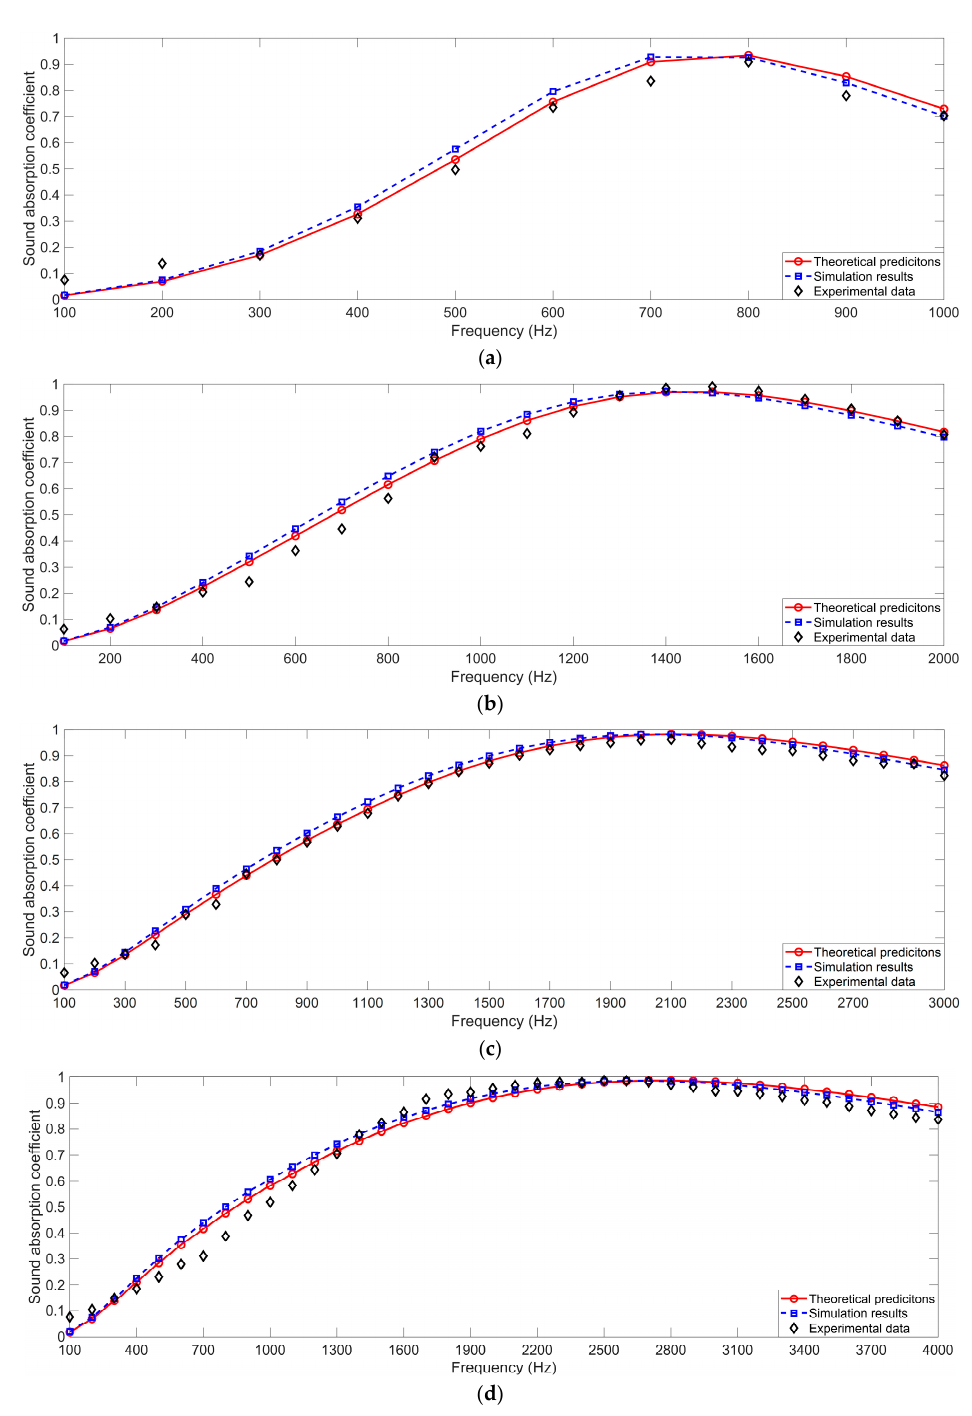
Figure 12. Comparisons of sound absorption coefficients of the composite sound-absorbing structure with variable target frequency ranges. ( a ) Optimal structure for 100–1000 Hz; ( b ) optimal structure for 100–2000 Hz; ( c ) optimal structure for 100–3000 Hz; ( d ) optimal structure for 100–4000 Hz.